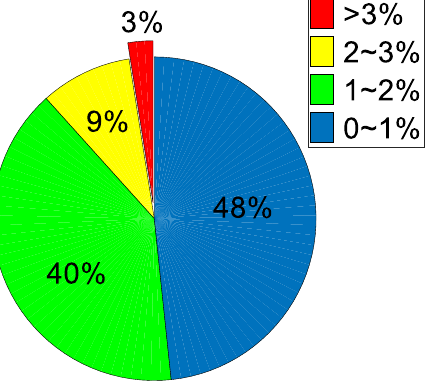
Figure 12. Proportions of relative error.